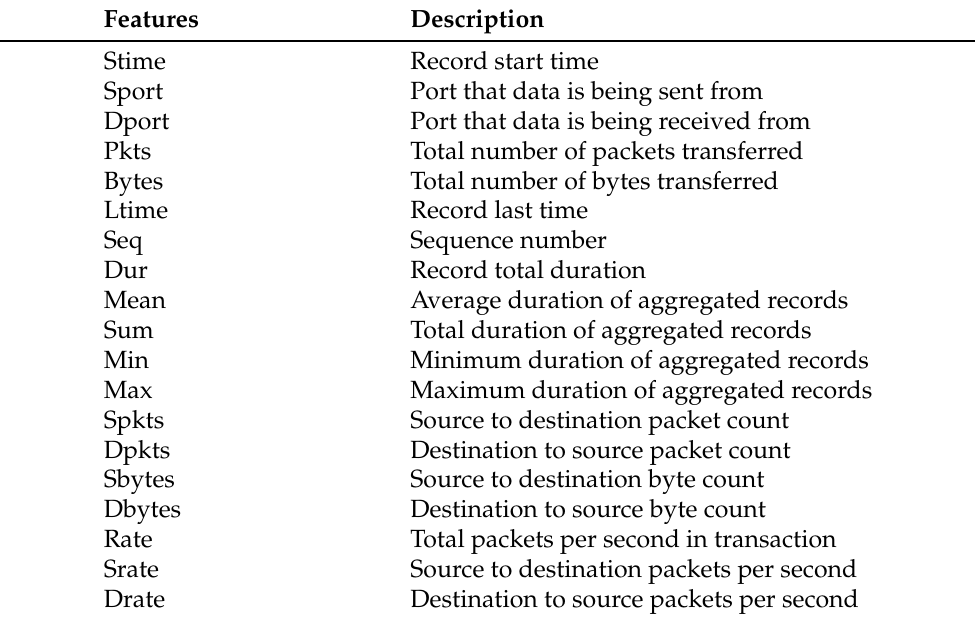
Table 4. Dataset features and